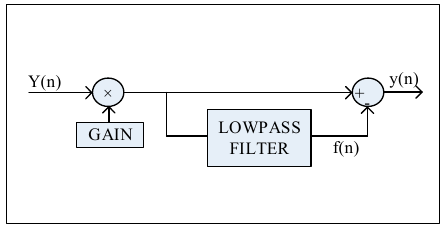
Figure 2. Temporal high-pass filter for adaptive nonuniformity correction (one filter per pixel).